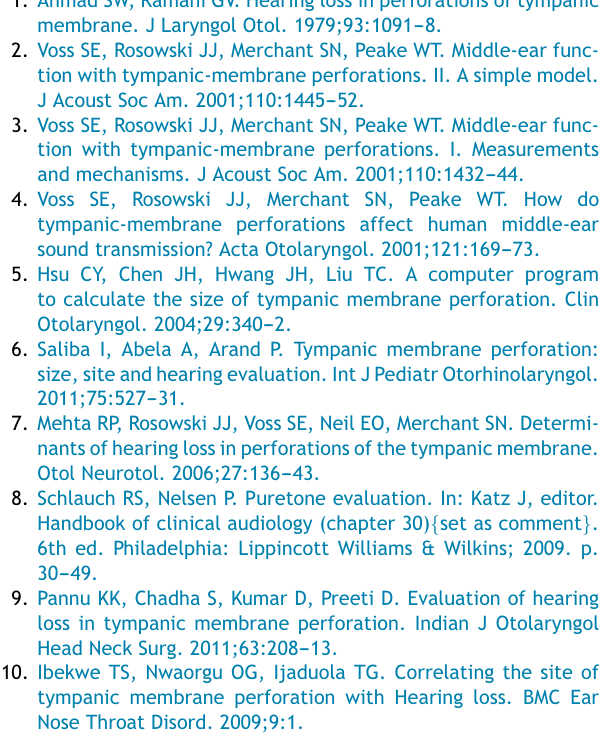
Correlation between percentage of tympanic mem- brane perforation and air-bone gap observed at a 4000 Hz